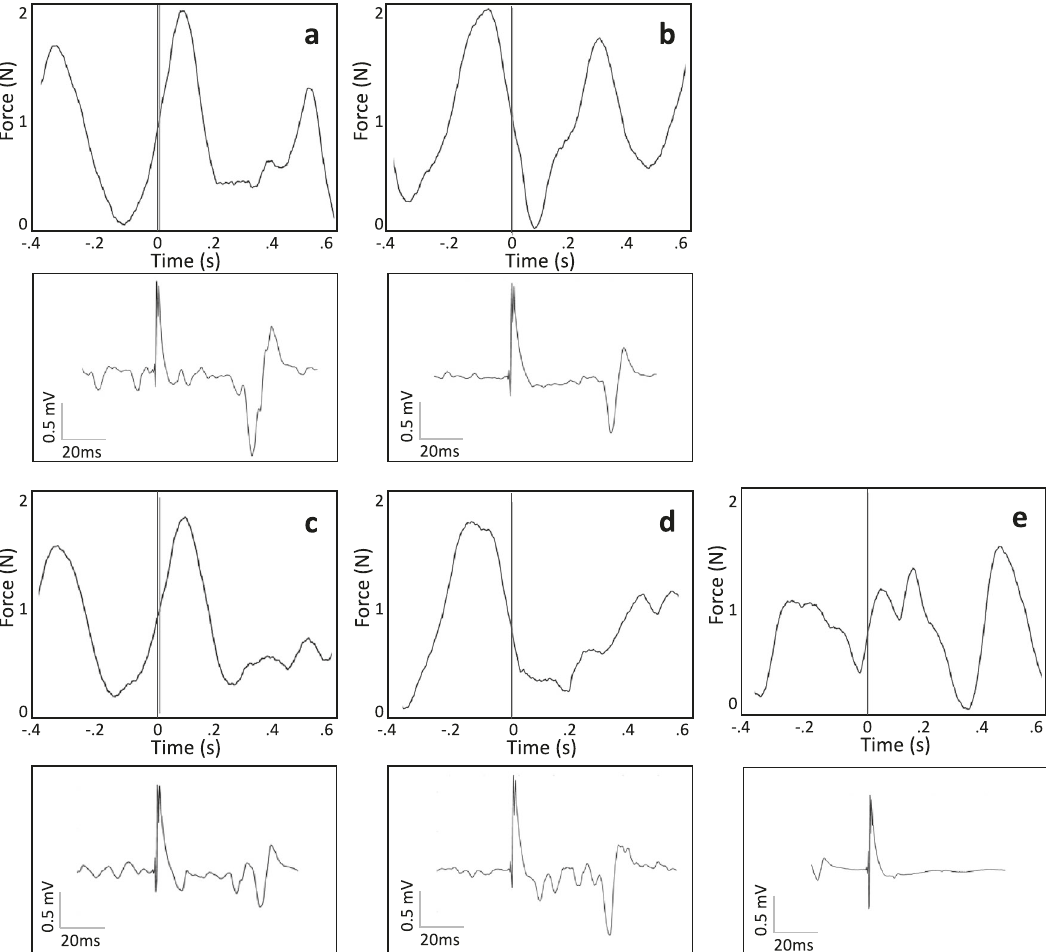
Fig. 4 Tapping sections with TMS pulses and corresponding MEPs (exemplary data from one patient). Top panels show sections of kinematic data, that is, continuous tapping (Force, (N)) over time (s) and the time point of the TMS pulse (grey vertical lines). Bottom panels show the corresponding MEP (Amplitude, (µV); 20 – 40 ms after TMS pulse) recorded over the right fi rst dorsal interosseus (rFDI). For the sake of clarity, different time scales have been chosen for kinematic and MEP panels, but overlay at time ‘ 0 ’ , i.e. TMS pulse. a regular tapping ascending (rTasc), b regular tapping descending (rTdesc), c transition period ascending (TRANSasc), d transition period descending (TRANSdesc), e freezing